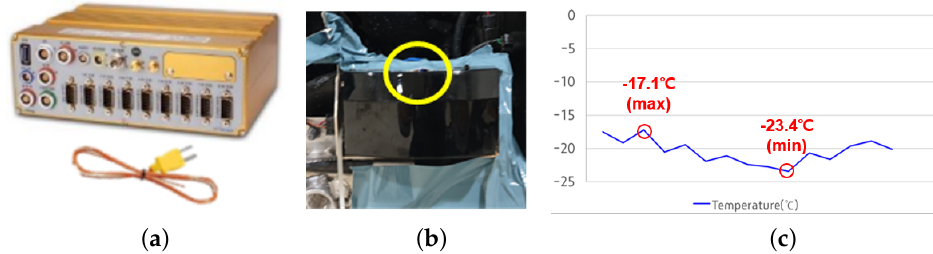
Figure 4. Car state logger example ( a ) IPETRONIK’s IPElog2 as a data acquisition toolbox. ( b ) Cover temperature measurement setup using a thermocouple. ( c ) Measured temperature profile in Alaska. The yellow mark indicates the attachment location of a wired thermal sensor connected to the IPElog2 (shown in ( a )).